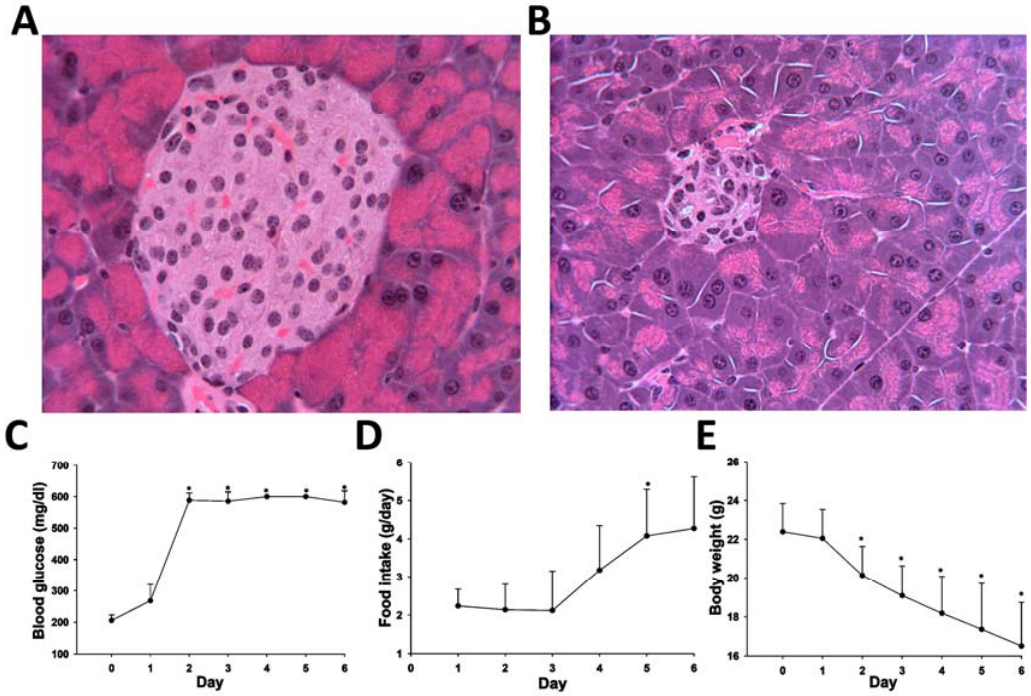
Figure 5. Phenotypes of streptozotocin (STZ)-induced Type 1 diabetes mouse